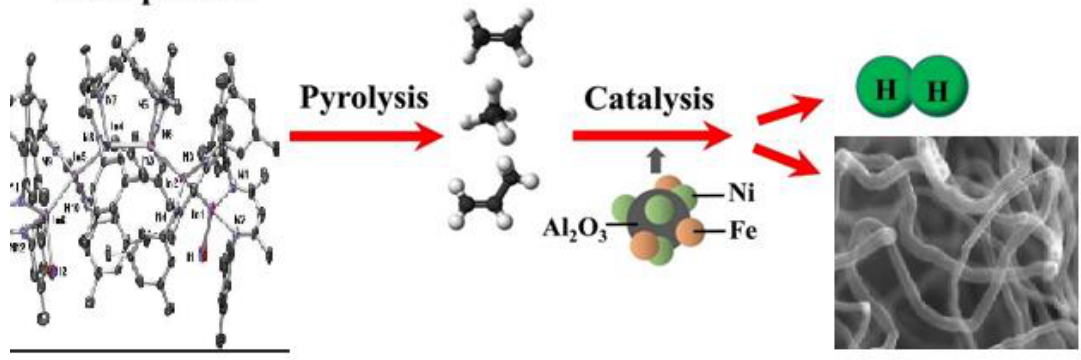
Figure 4. Schematic of pyrolysis of polymer with catalyst and hydrogen release.